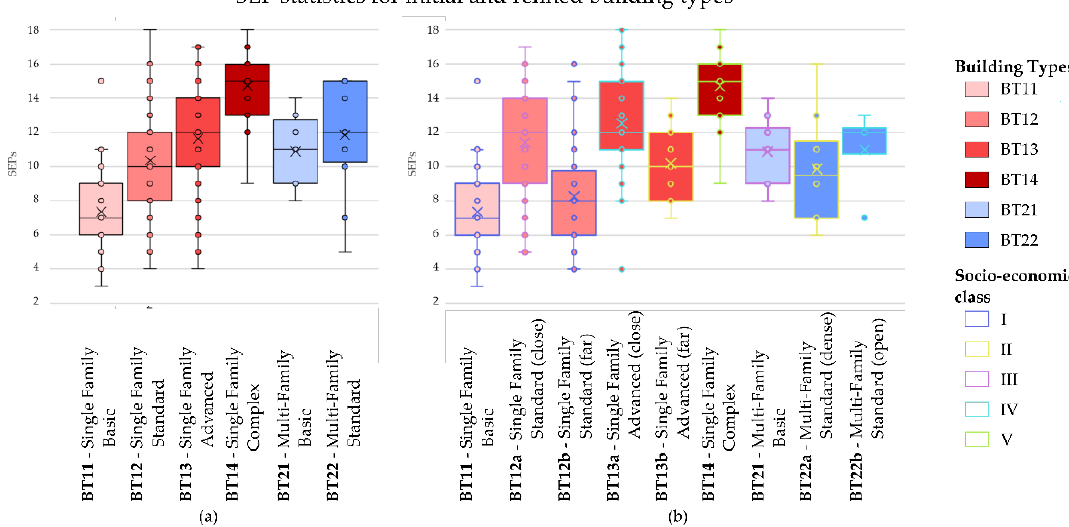
Figure 10. Boxplot chart showing statistical distribution of SEPs over building types. ( a ) Initial building typology with high SEP variation in building type classes 12, 13, and 22. ( b ) The statistical distribution of SEP on refined building typology with effect of reduced variation of SEP for the building type classes 12a/b, 12a/b, and 22a/b. In ( b ), socio-economic class (SEC) assignment is indicated by colored contours (SEC I: blue, SEC II: yellow, SEC III: pink, SEC IV turquoise, SEC V: green). For detailed statistics see Appendix E.